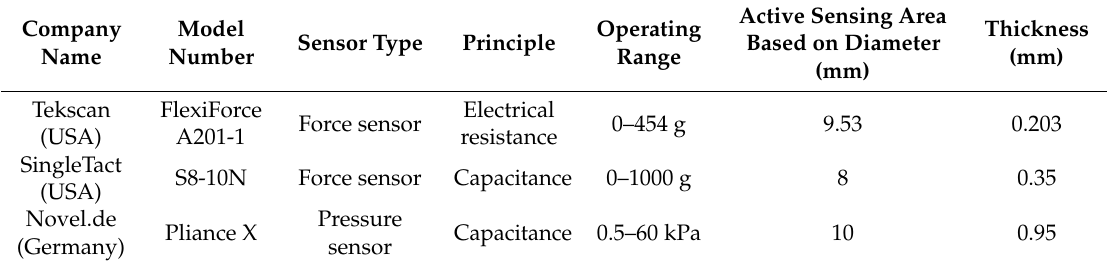
Figure 2. Evaluated force and pressure sensors: ( a ) SingleTact force sensor, ( b ) FlexiForce ® sensor and ( c ) Pliance X pressure sensor. Table 1. Sensor